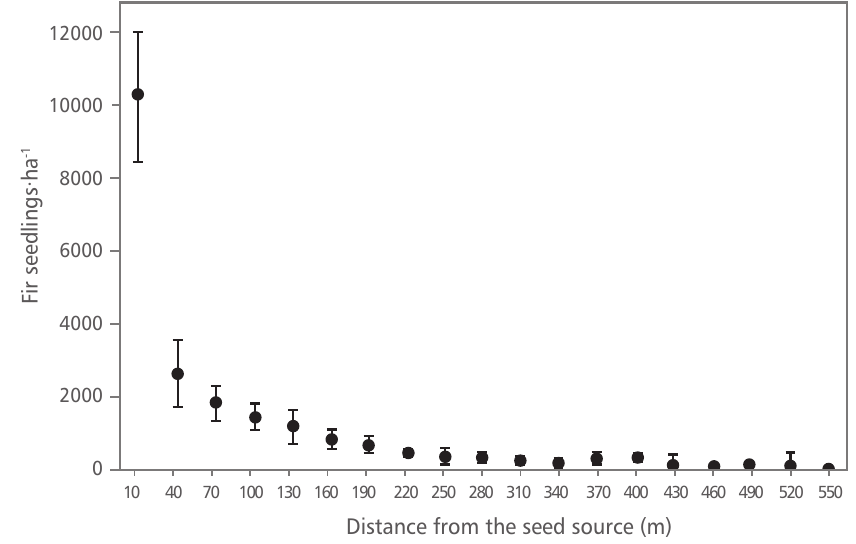
intervals.Distance from the seed source FIGURE 1. Fir seedling densities observed at various distances from the seed source. Dots represent the mean with 95% confidence